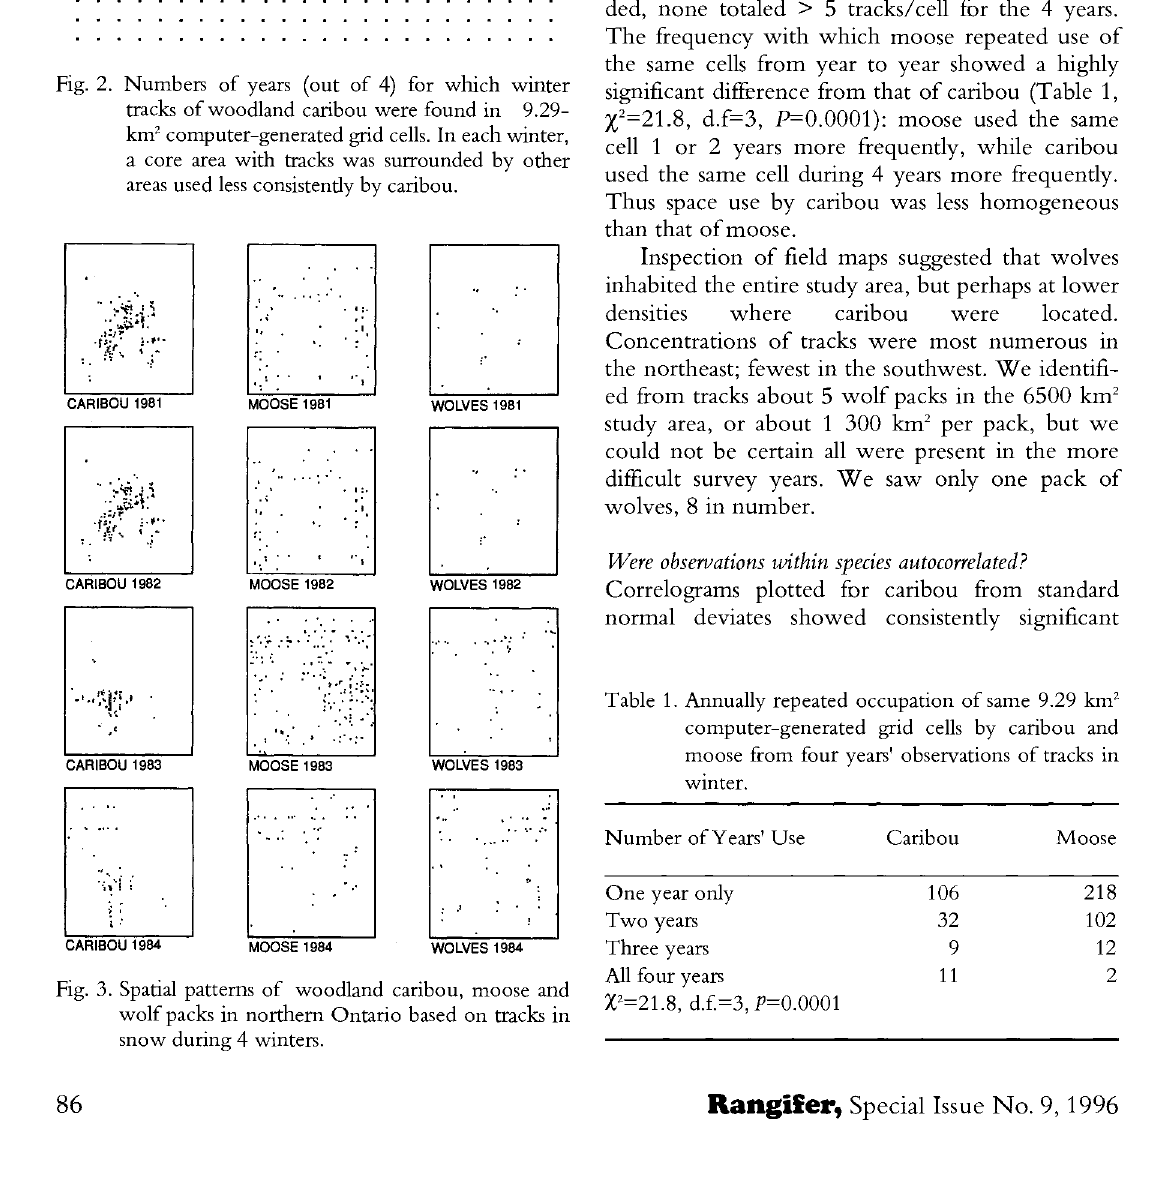
Fig. 2. Numbers of years (out of 4) for which winter tracks of woodland caribou were found in 9.29- km 2 computer-generated grid cells. In each winter, a core area with tracks was surrounded by other areas used less consistently by caribou.